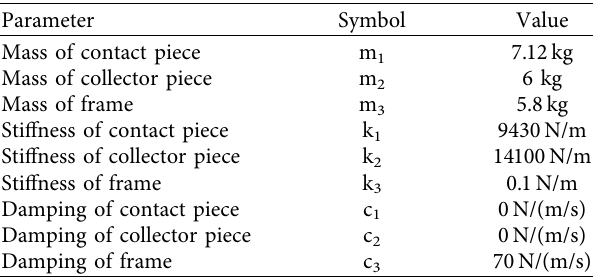
Figure 2: Dynamic modeling of the pantograph. Table 2: Parameters of the pantograph.